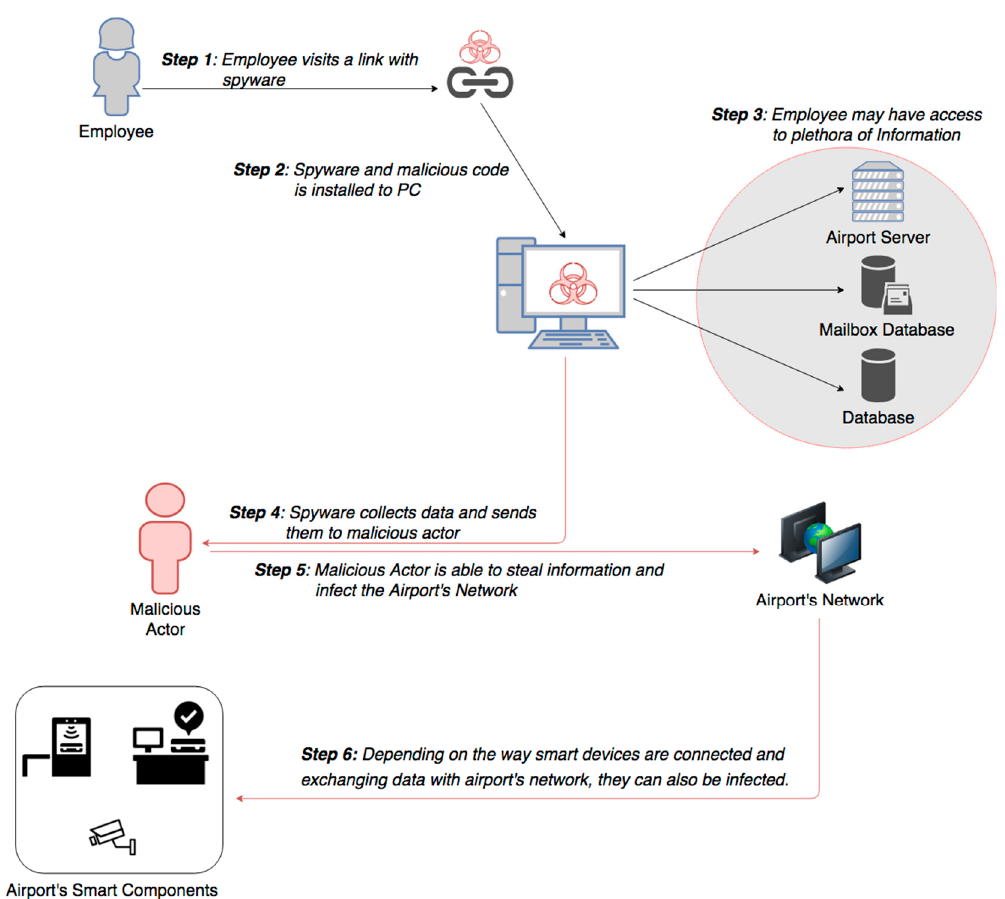
Figure 12. Misuse of authorization with APT.